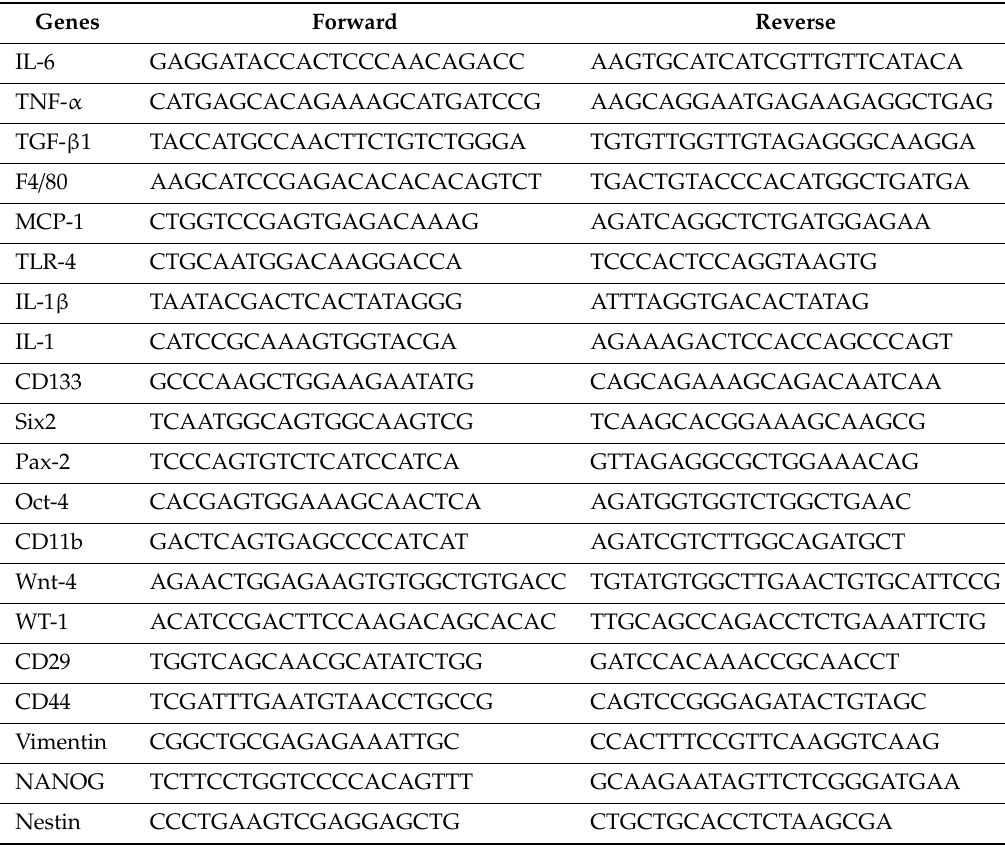
Table 1. The primer sequences for quantitative real-time (qRT)-PCR. IL, interleukin; TNF, tumor necrosis factor; MCP, monocyte chemotactic protein.